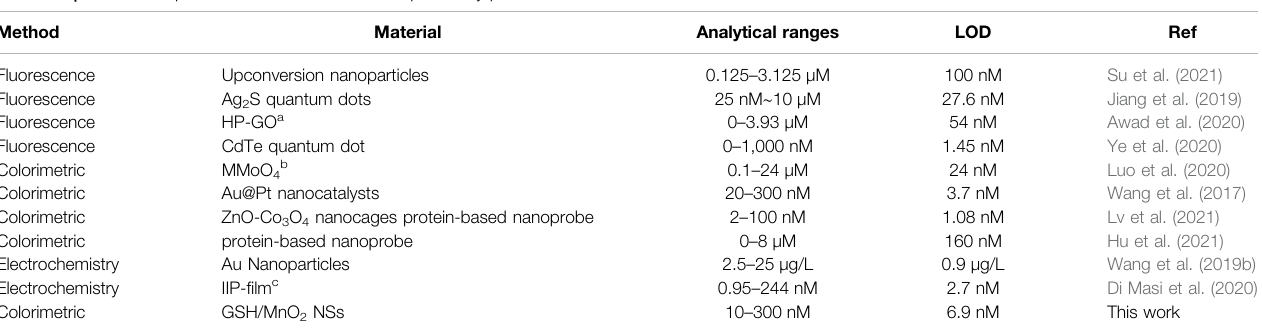
TABLE 1 | The list comparison of this work with other previously published works. Method